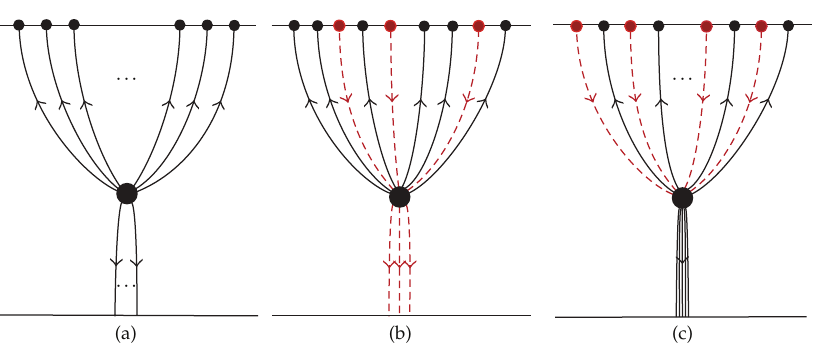
Figure 1: An illustration of the holographic multiquark states (cid:3) a (cid:4) k -baryon with k h (cid:8) k < N c and k r (cid:8) N c − k , (cid:3) b (cid:4) (cid:3) N c (cid:9) k (cid:4) -baryon with k h (cid:8) N c (cid:9) k and k r (cid:8) k , and (cid:3) c (cid:4) j -mesonance with k h (cid:8) 2 j and k r (cid:8) N c